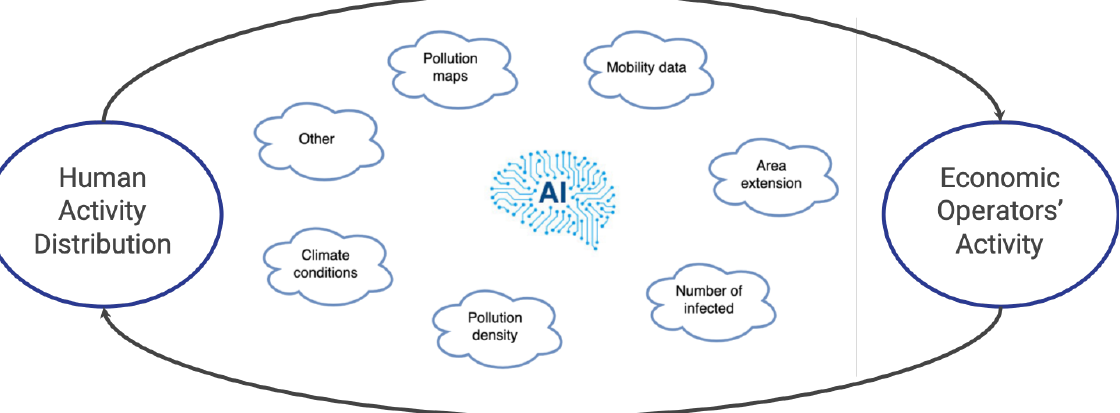
Figure 1. Data sources.